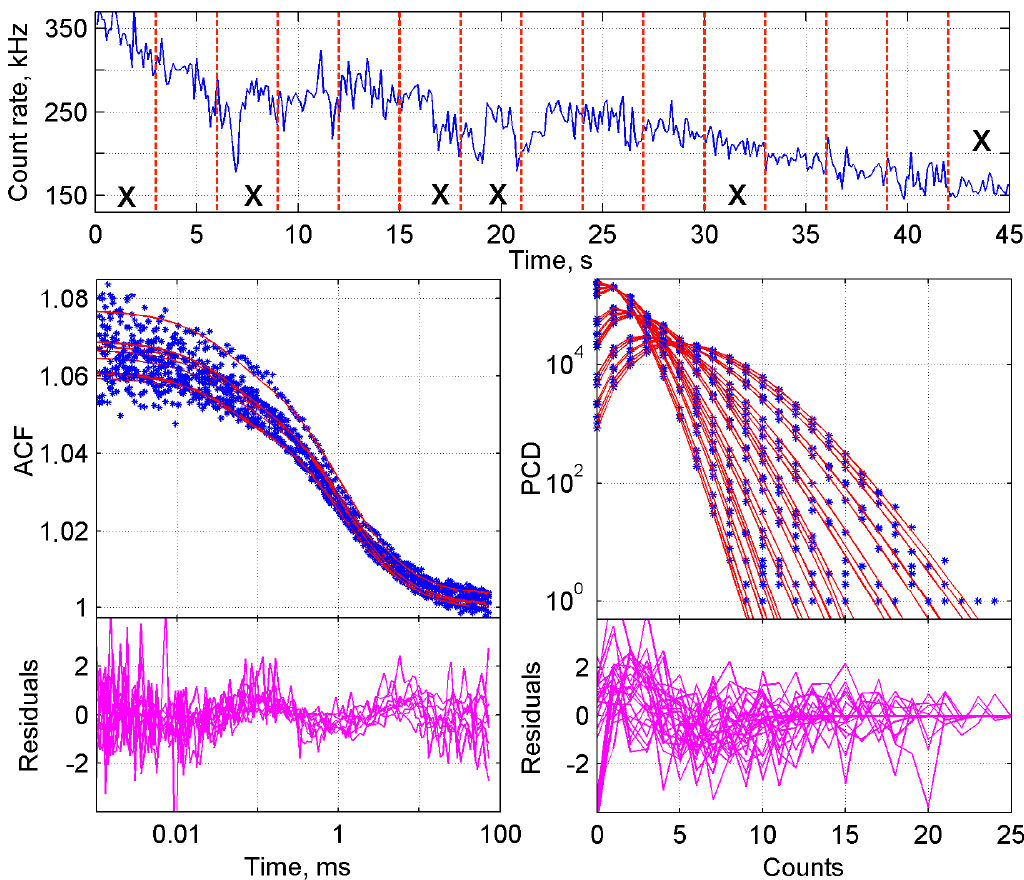
Figure 5. Results of BDGA analysis of the ACF and PCD curves from a monomer-dimer equilibrium of FKBP12 in living cells. The sample consisted of cells expressing FKBP12-GFP, supplemented with dimerizer. Panels are explained in Figure 1. The measurement was divided into fifteen 3-s traces. Traces marked with an ‘X’ have been deleted based on visual inspection of the ACF curves. PCD curves were generated with three different time steps of 5 × 10 − 6 , 1 × 10 − 5 , and 2 × 10 − 5 s, respectively.